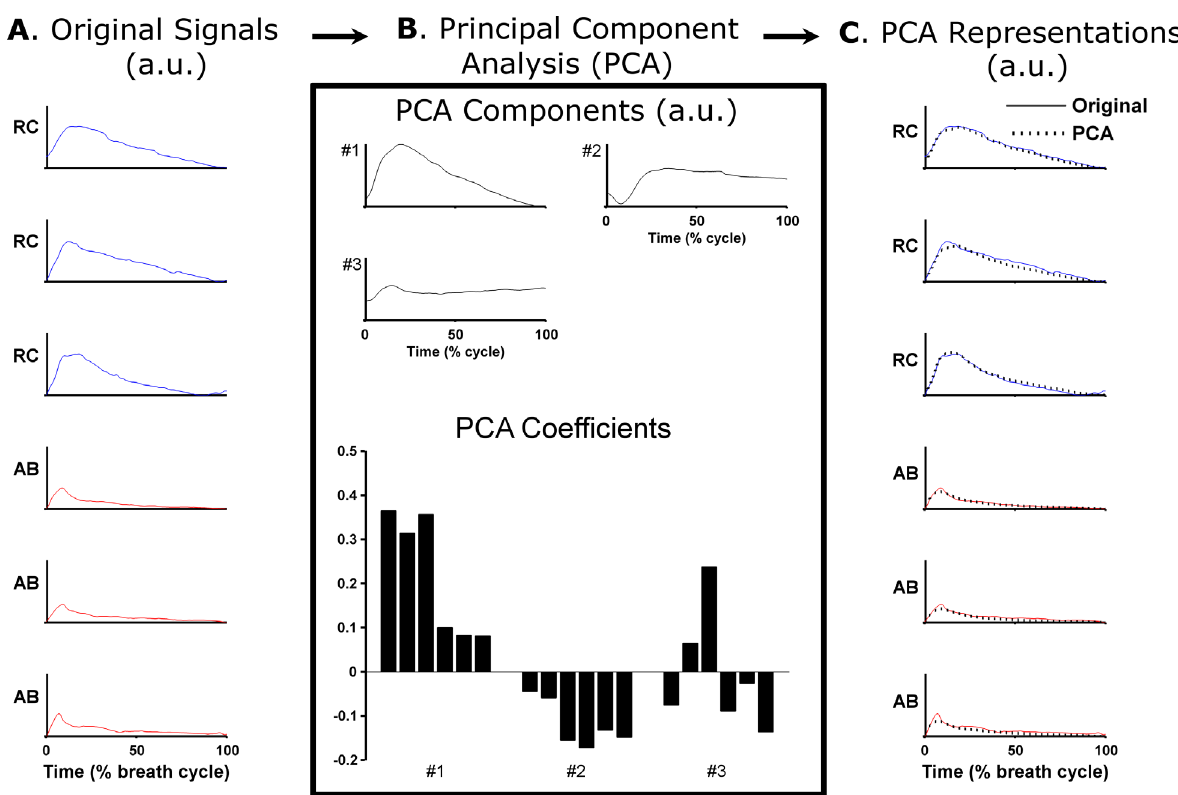
Fig 2. Example of extraction of typical breathing patterns using Principal Component Analysis (PCA). In A, rib cage (RC) and abdominal (AB) volumes are shown for three consecutive breath cycles of a classical singer performing a singing task (task 1: Waltzing Matilda). These waveforms were used to calculate the PCA components and PCA coefficients shown in B. In this example, three components explained more than 98% of the total variability of the original signals. The PCA representations in C were obtained by weighting the PCA components by the corresponding PCA coefficients. The typical breathing pattern for this subject (not shown) was obtained by weighting the PCA components by the average PCA coefficients across all breath cycles. a.u.: Arbitrary units.